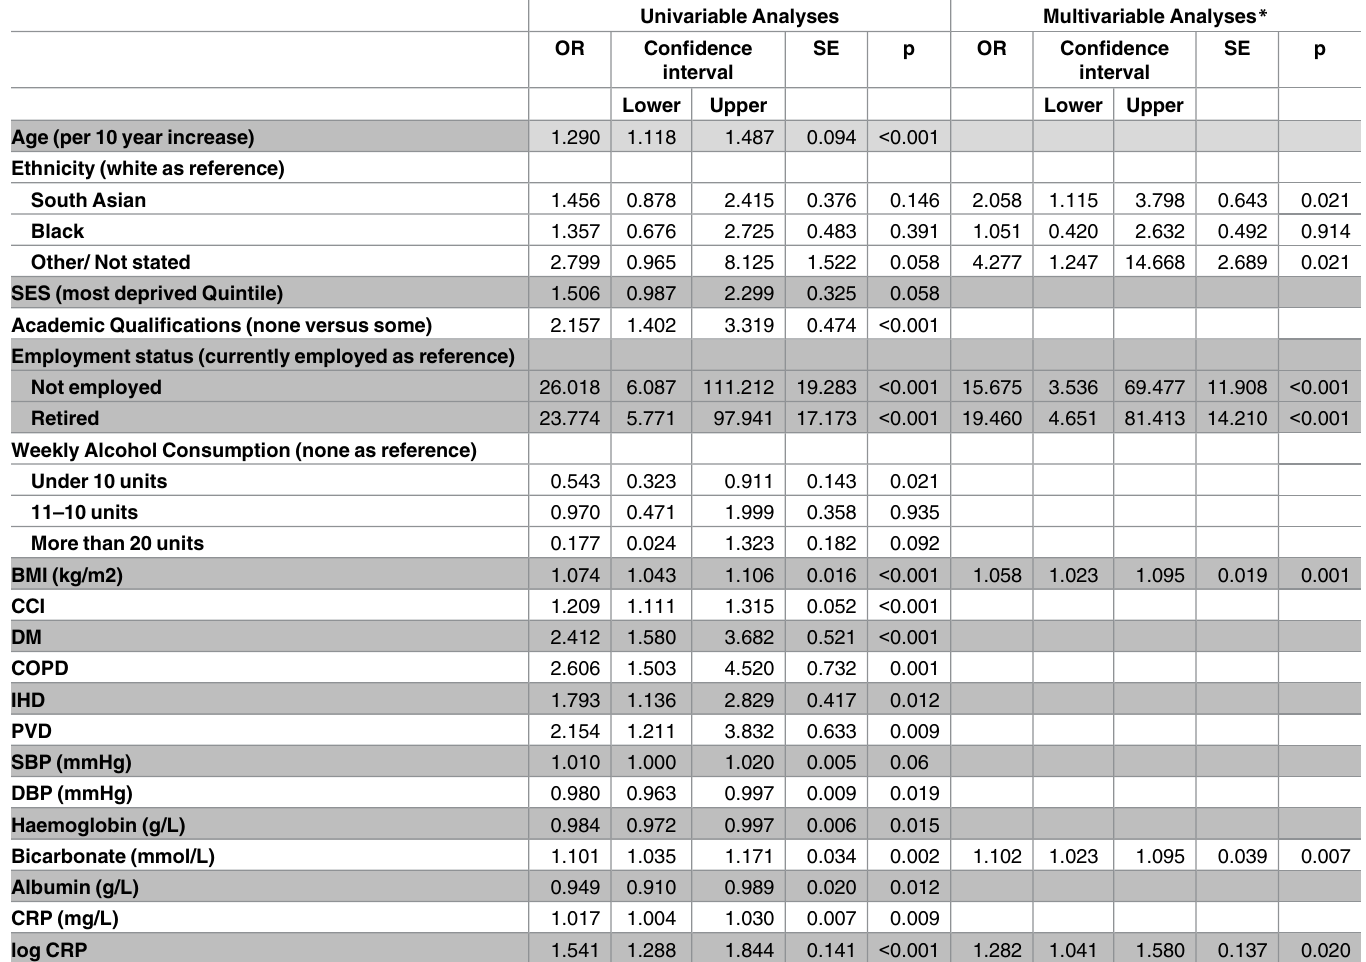
Table 7. Variables predictive of reported problems with self-care by logistic